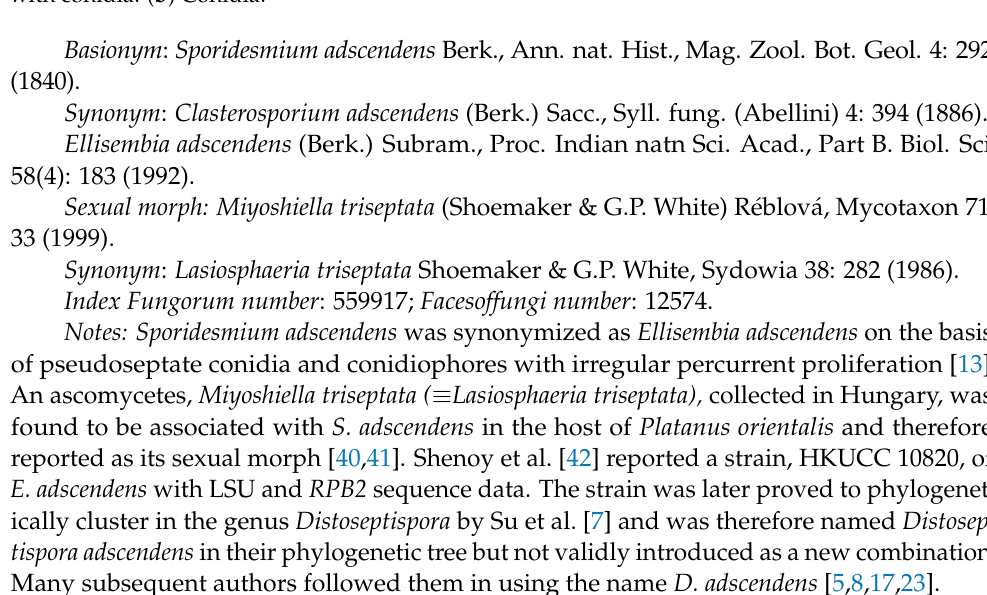
Figure 2. Distoseptispora adscendens . (redraw according to Wu and Zhuang [14]). ( a ) Conidiophores with conidia. ( b )